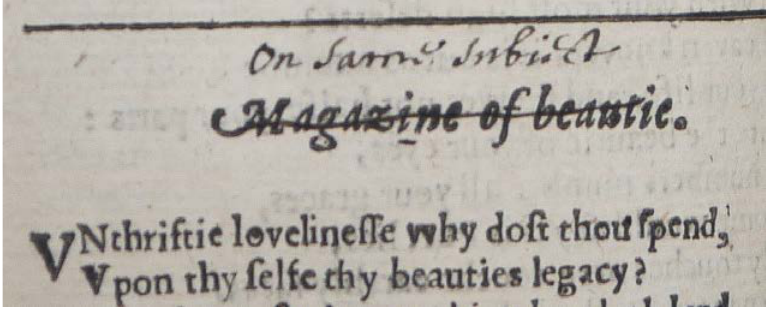
Fig. 4 – Folger STC 22344 Copy 2, sig. A7v